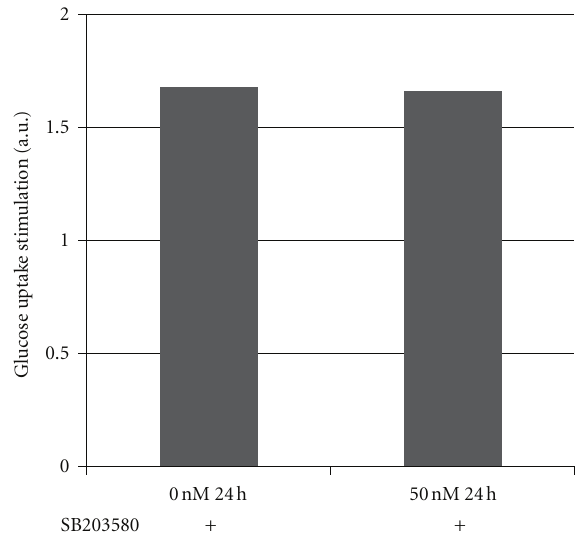
Figure 6: C2C12 cells were di ff erentiated from myoblasts to myotubes as described in the Materials and Methods